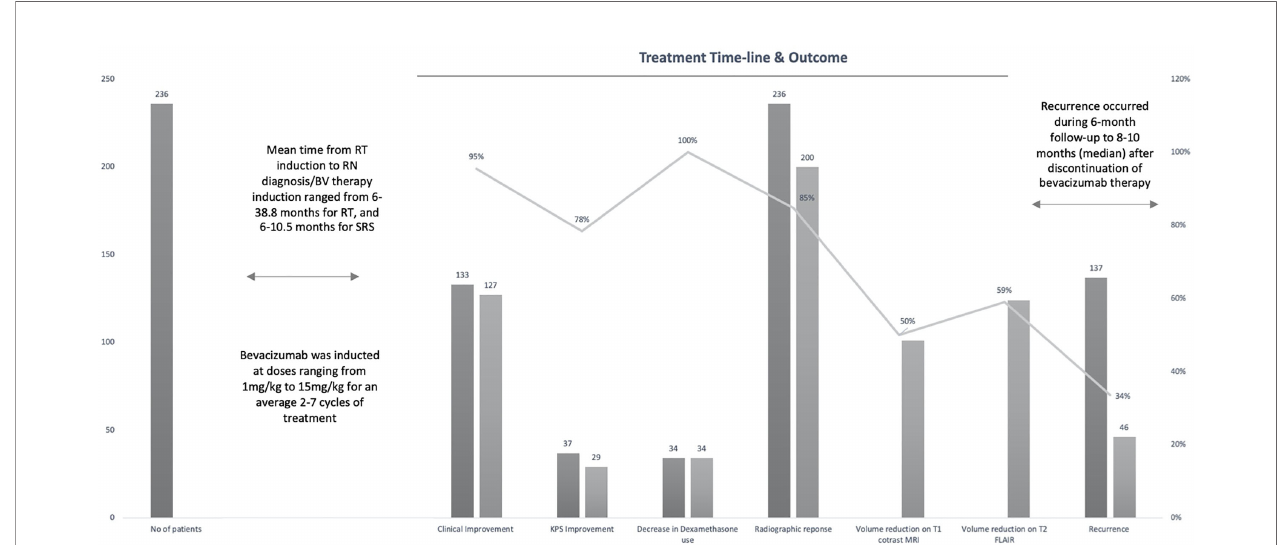
FIGURE 4 | Graph showing timeline of entire study population from radiation therapy (RT) induction to radiation necrosis (RN) diagnosis/bevacizumab (BV) treatment to recurrence with main outcomes of